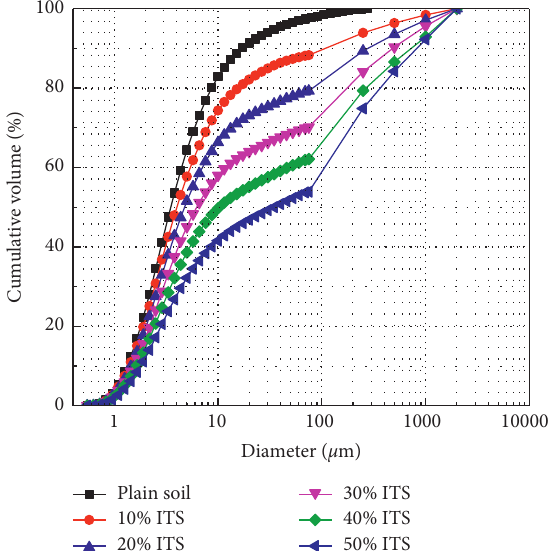
Figure 3: Particle size distribution range of the ITS treated ex- pansive soil.